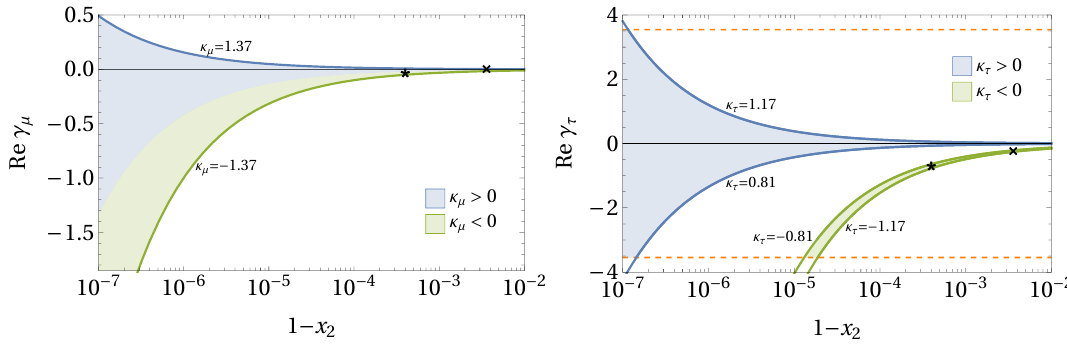
Figure 1 . The possible values of the real parts of the Yukawa couplings γ µ (left panel) and γ τ (right panel) versus 1 − x , according to inequalities (2.44d) and (2.44b), respectively. In the right 2 √ panel, the dashed orange lines indicate the upper bound | Re γ 4 π ≈ 3 . 5 that we impose in our τ | ≤ fits. The locations of the benchmark points of table 3 are marked by crosses (for BP-1) and stars (for